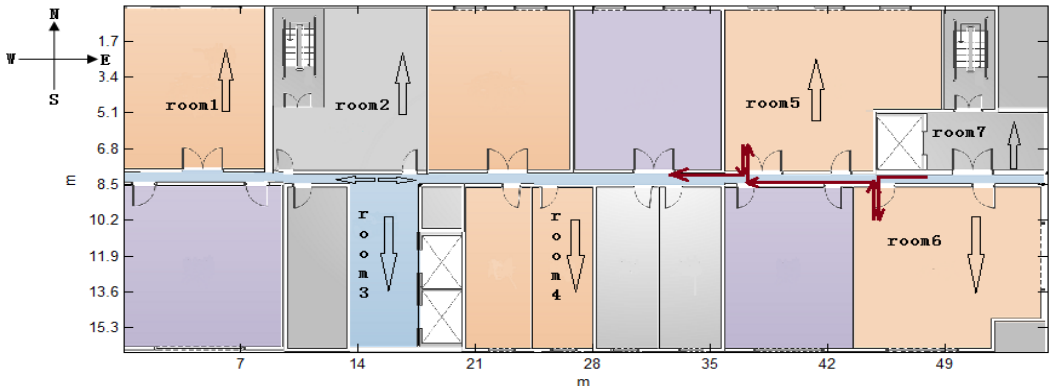
Figure 9. The map of the 8th floor in the main building of the Academy of Opto-Electronics.